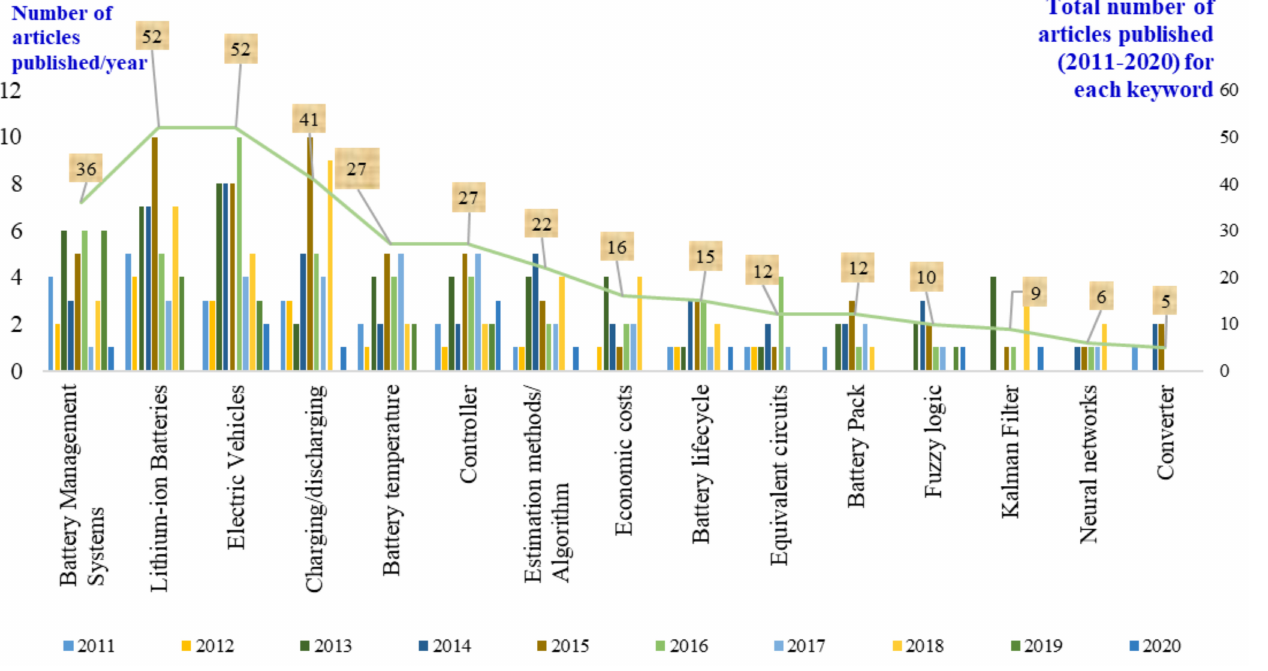
Figure 4. Top 15 widely utilized keywords distributed over the 110 most cited articles in BMS technology for EV